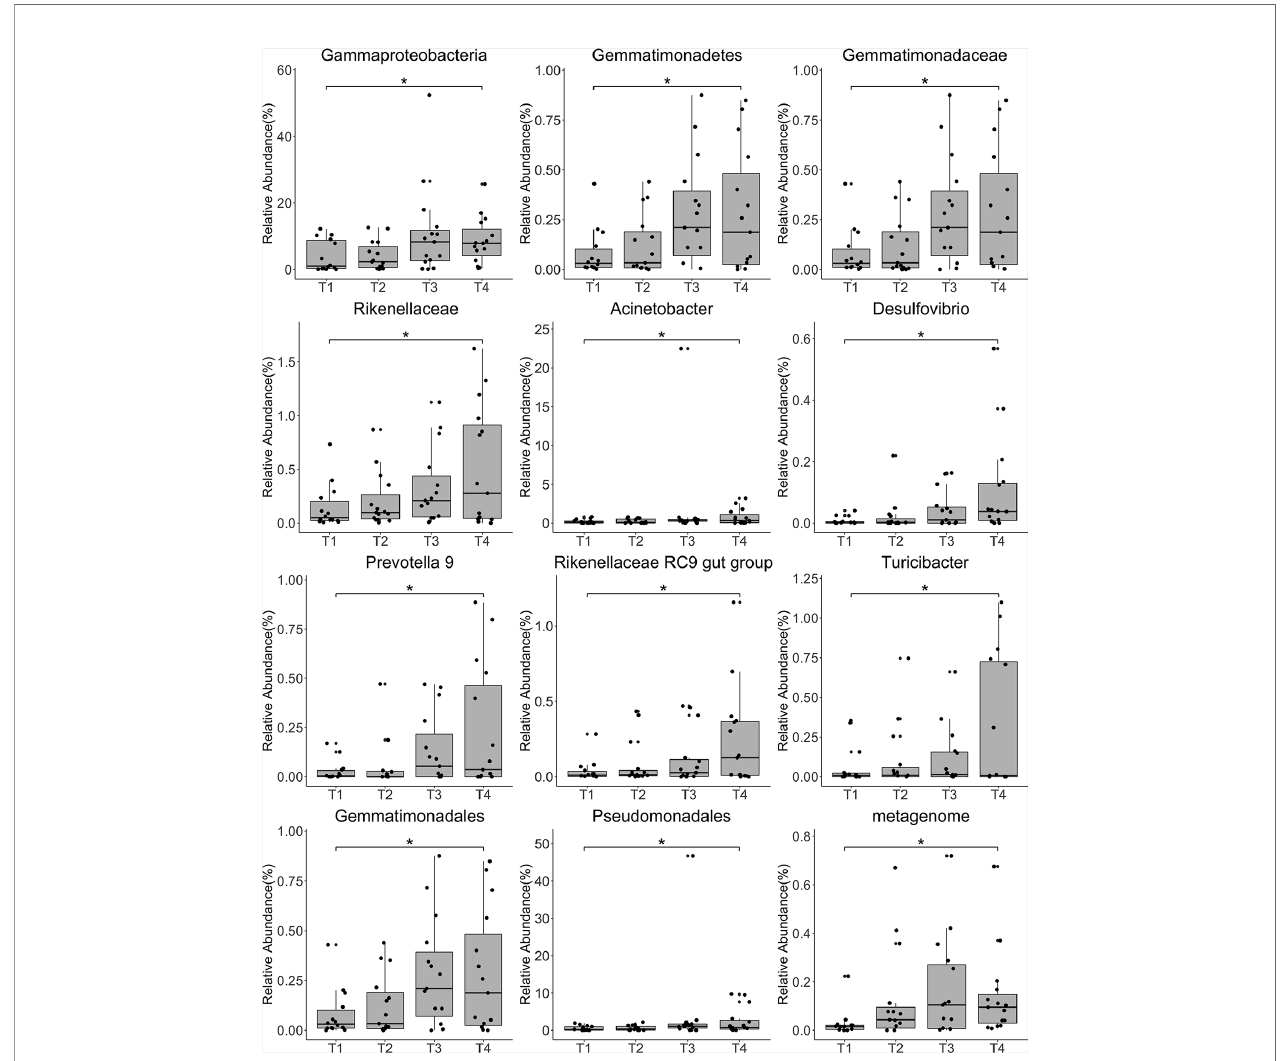
FIGURE 5 | Relative abundances of the top 12 most abundant genera at each time point. Each bar represents the mean abundance ± the standard error of the mean. * P<